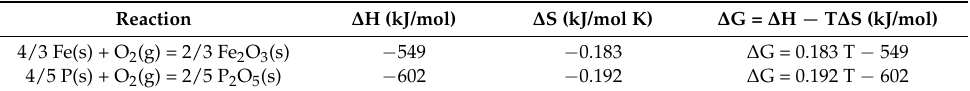
Table 4. The changes of enthalpy ∆ H, entropy ∆ S, and Gibbs free energy ∆ G corresponding to the oxidation reactions of Fe and